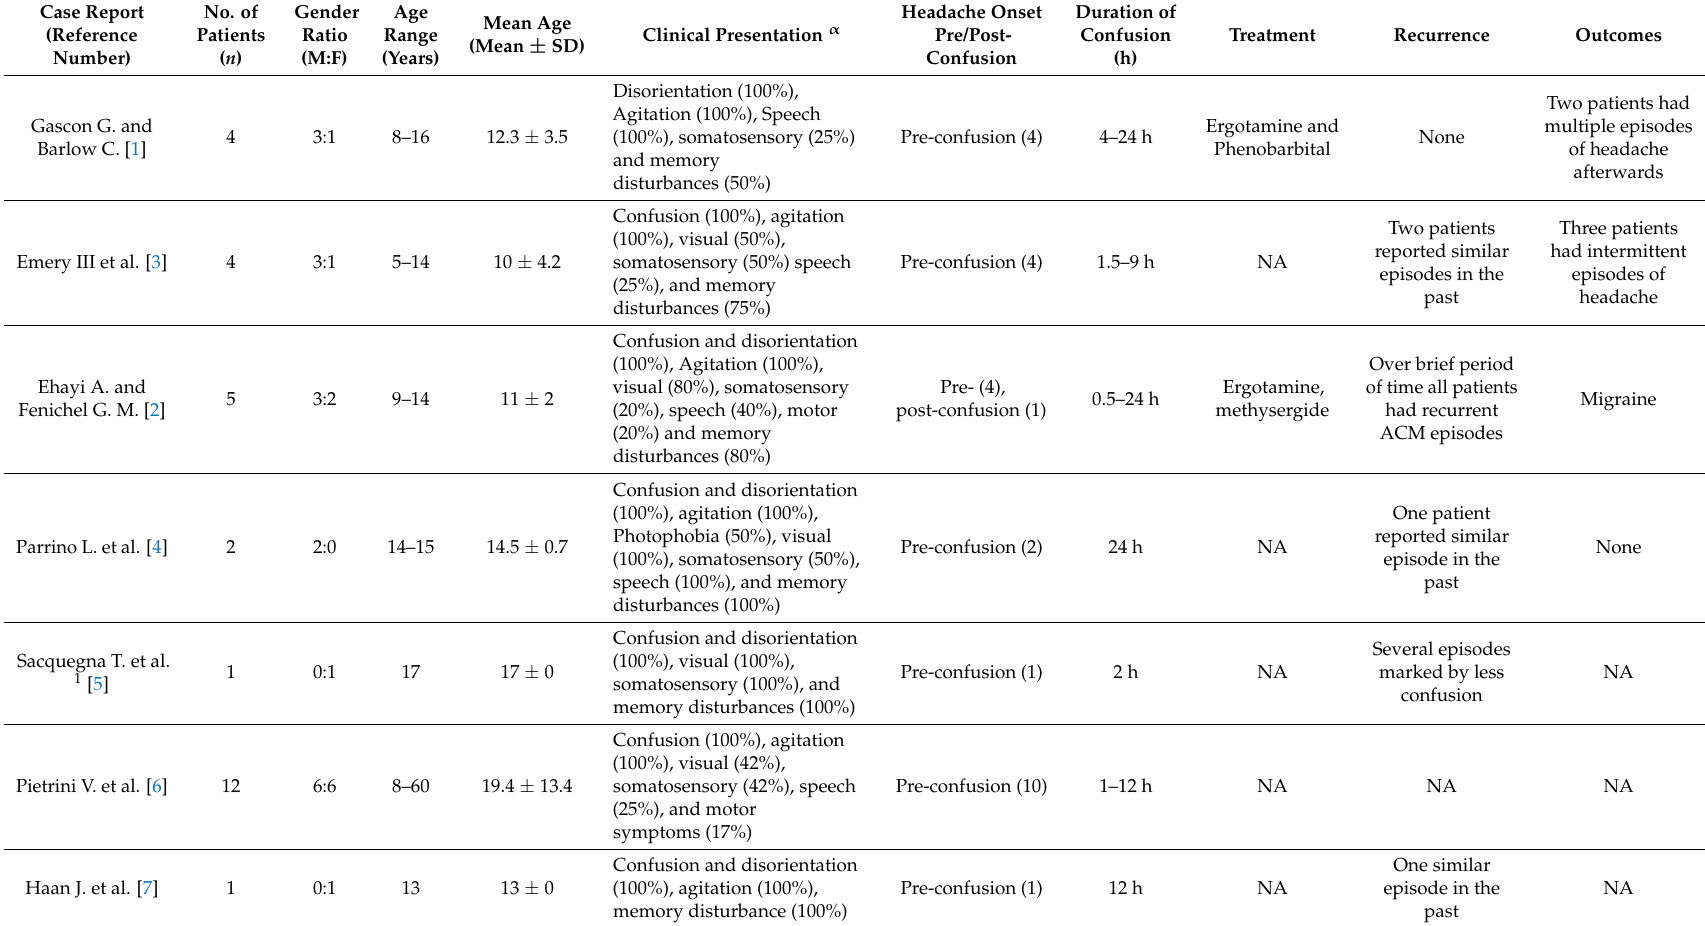
Table 1. Brief description of previously reported cases of acute confusional migraine including demographic information of the patients (age, gender), clinical presentation (predominant symptoms and percentage of people exhibiting that symptom, onset of headache relative to confusion, duration of confusional state), treatment, and routine follow up if any (recurrence and outcomes)